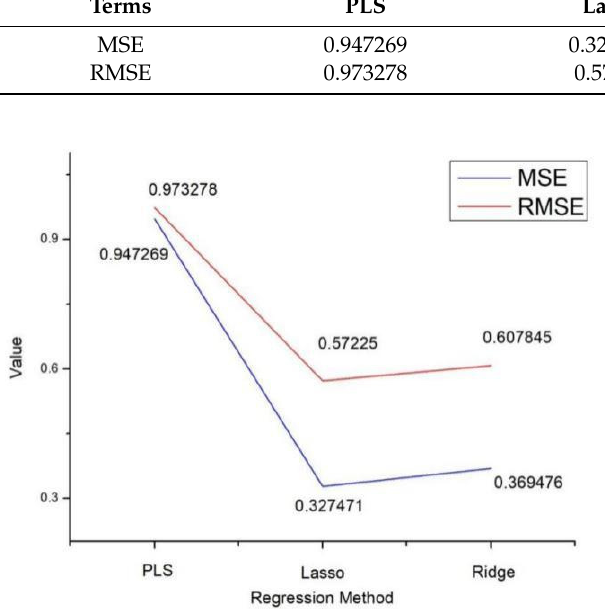
Figure 3. Comparison of MSE and RMSE values of three models.